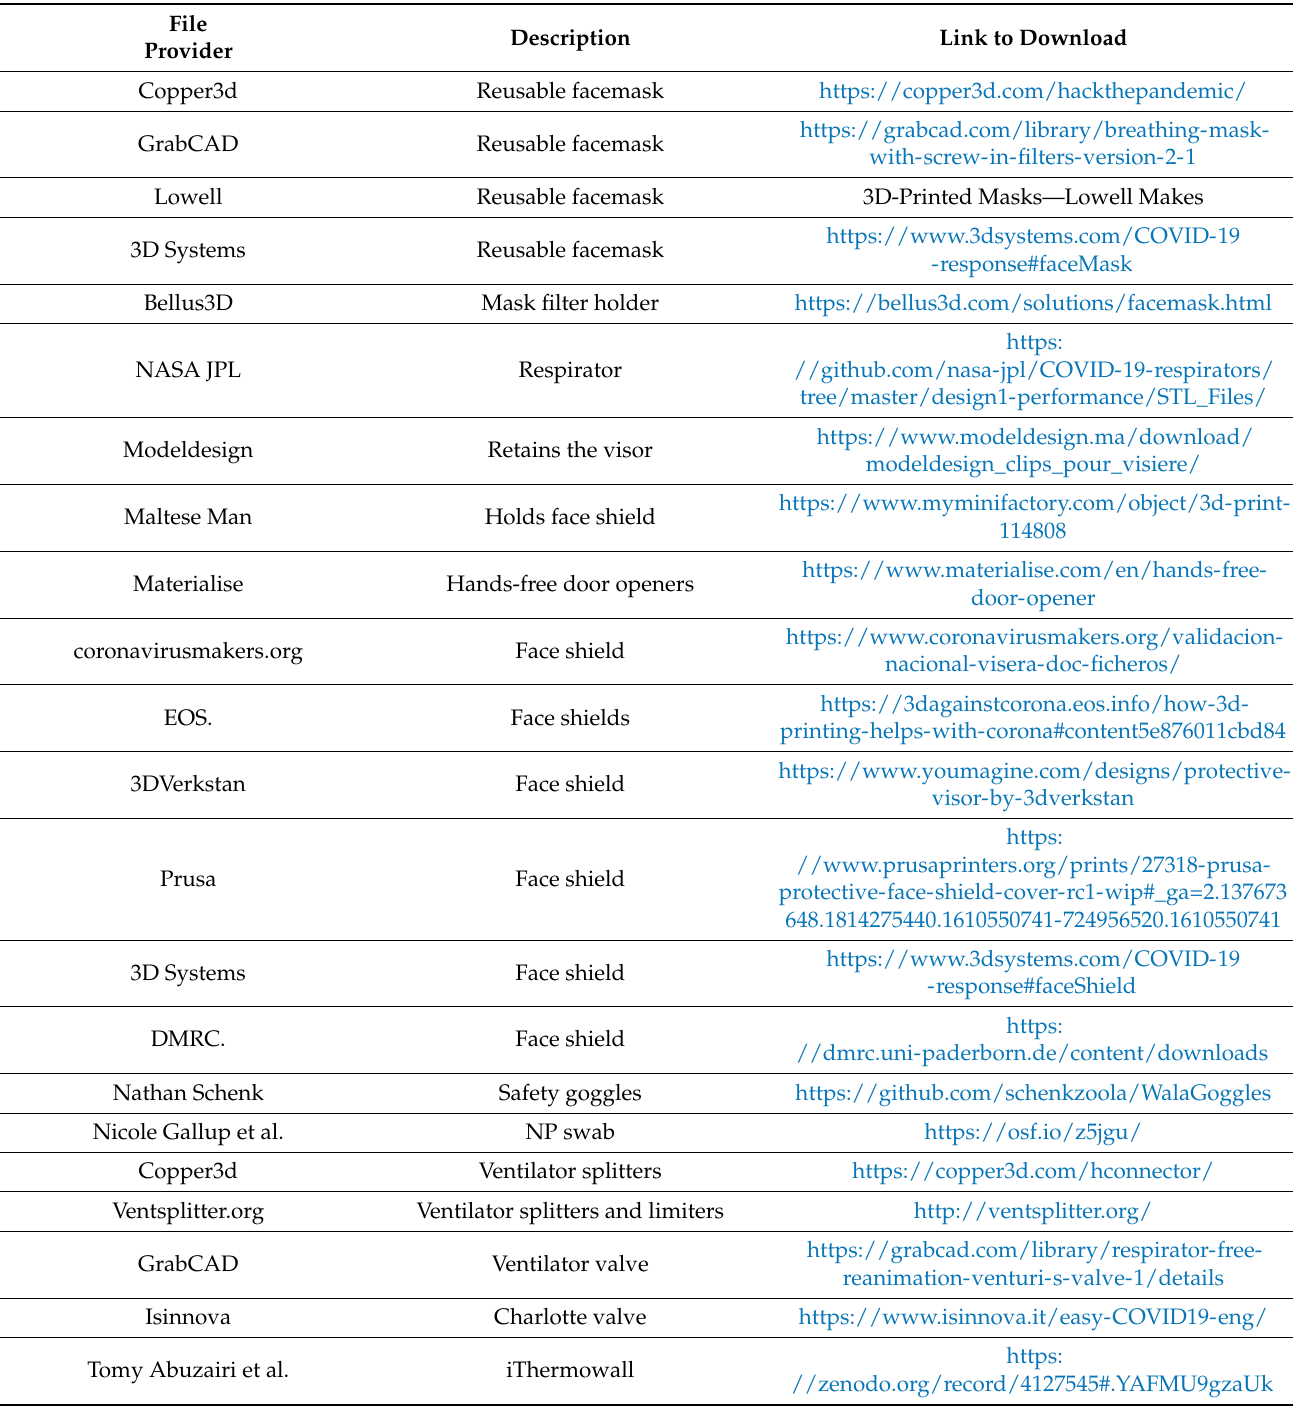
Table A1. A few available open-source 3D printable files for hobbyists or professionals. All the website in this table accessed on 22 August